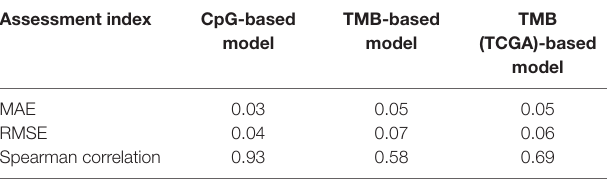
TABLE 4 | Comparison of model